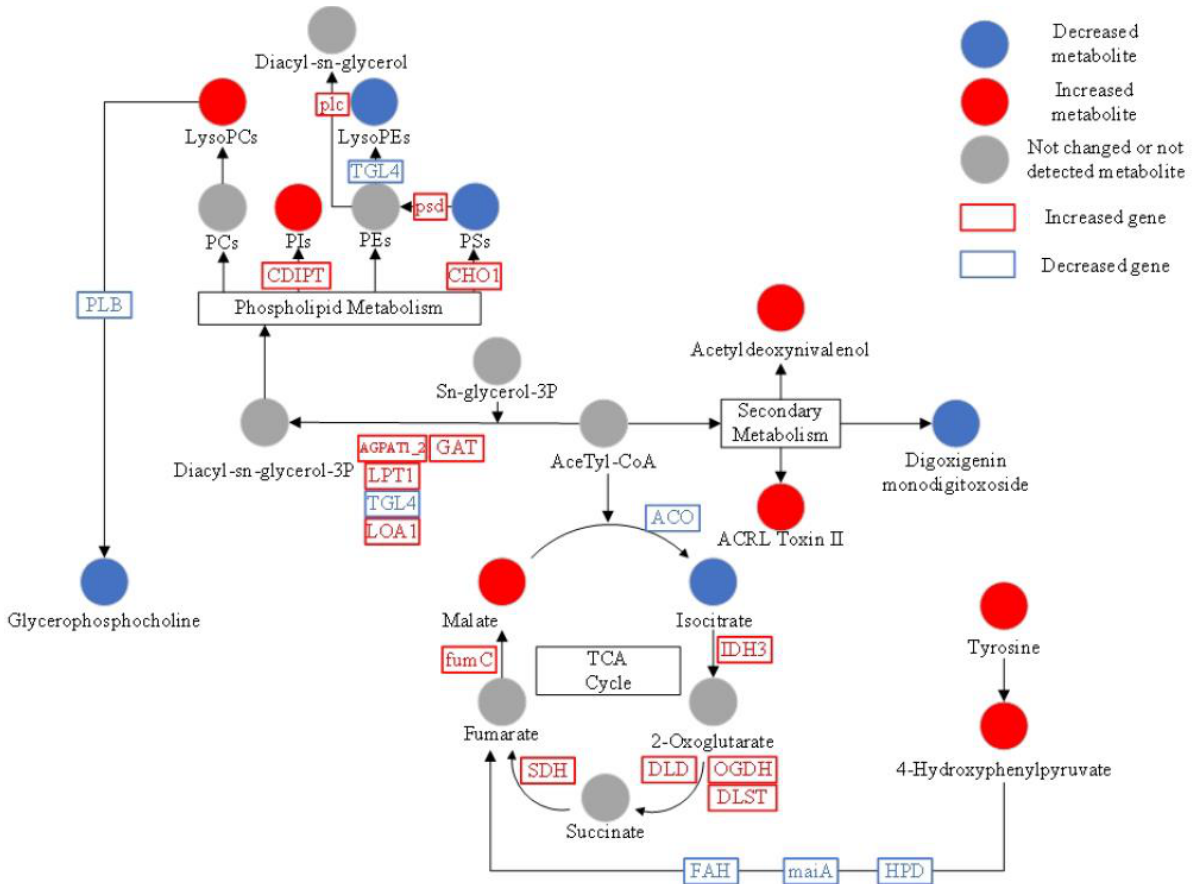
Figure 7. Overview of significantly altered metabolic profiles in Mlae1 and T23 strains. Red and blue colors represent upregulated and downregulated metabolites in Mlae1 relative to the level in T23, respectively.